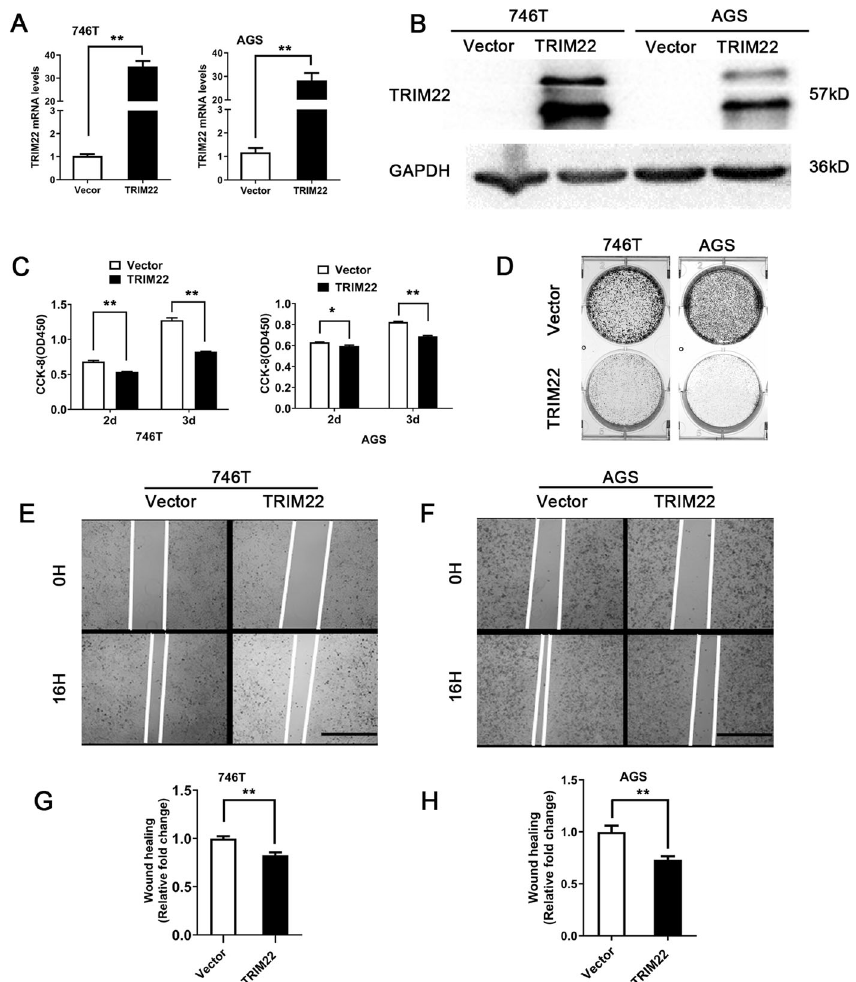
Fig. 2 TRIM22 overexpression inhibited the proliferation and migration of gastric cancer cells in vitro. A , B Validation of the transfection ef fi ciency of TRIM22 (qPCR and WB, * P < 0.01). 746 T and AGS cells were transfected with TRIM22 lentivirus to construct stably transfected cells. C , A CCK-8 assay was used to detect cell proliferation (* P < 0.01). D colony formation assay. E , F A wound-healing assay was used to detect wound-healing ability. G , H Statistics of wound-healing area (** P < 0.01, scale bars = 1000 μ m). Data are shown as mean ± SD of three independent